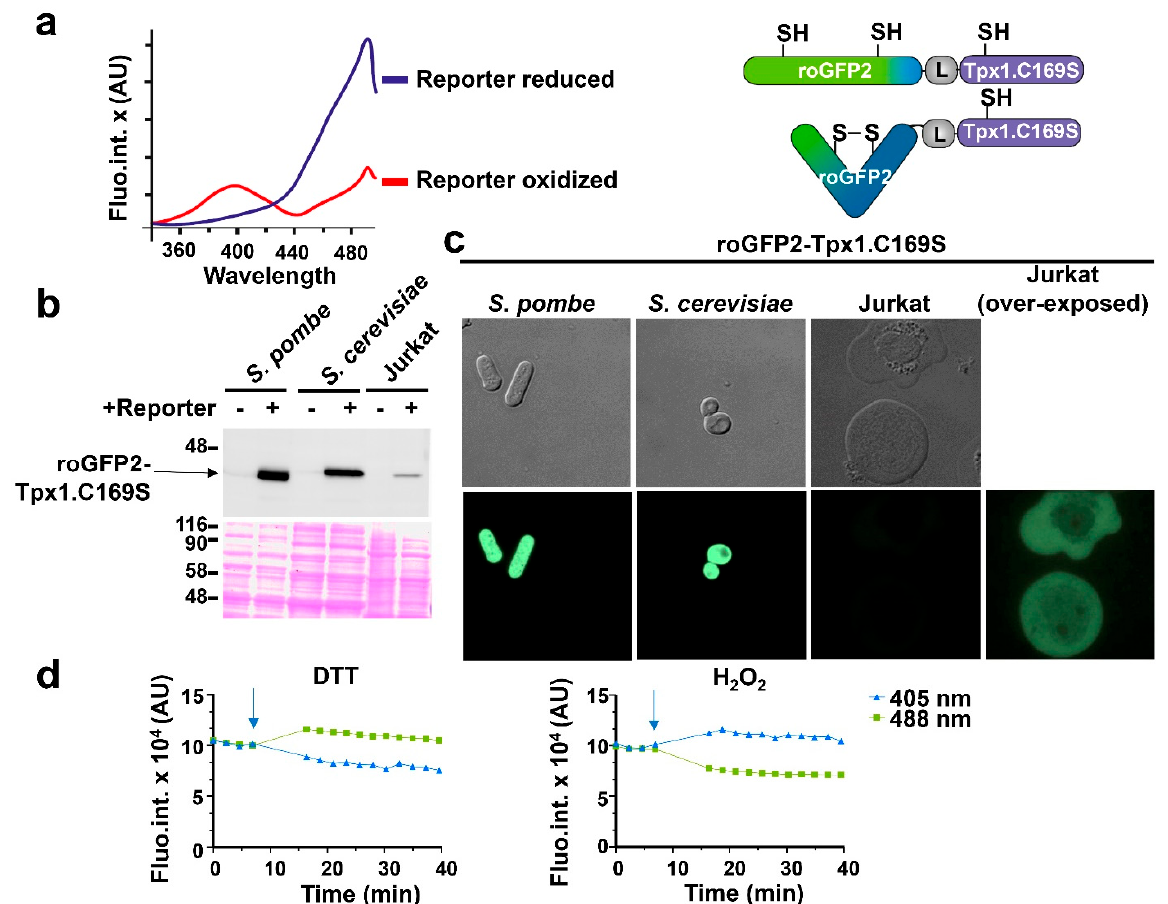
Figure 1. Expression of the H 2 O 2 biosensor roGFP2-Tpx1.C169S in fission and budding yeasts and in Jurkat T cells. ( a ) Left: representation of the fluorescence excitation spectra of reduced and oxidized roGFP2-Tpx1.C169S. The blue line is the fully reduced reporter form and the red line represents the fully oxidized form. X-axis: excitation wavelengths. Y-axis: AU (arbitrary units) of emission fluorescence at 520 nm. Right: representation of the reduced (up) and the oxidized (down) states of roGFP2-Tpx1.C169S. Upon H 2 O 2 treatment, cysteine 48 of Tpx1 oxidizes to sulfenic acid and afterward oxidizes roGFP2, which forms a disulfide bond. ( b ) Western blot of the three used models. Cells expressing or not the probe roGFP2-Tpx1.C169S were processed as described in Materials and Methods. Strains of S. pombe (HM123) and S. cerevisiae (BY4741) were transformed with plasmids p407.C169S and p791 (+) and processed in parallel with their counterparts not expressing the reporter (972 or BY4741, respectively) (-). For Jurkat T cells, extracts from cells stably transfected or not with plasmid p797 to express roGFP2-Tpx1.C169S were grown and processed as described in Materials and Methods. Ponceau staining was used as a loading control. The sizes of molecular weight markers (in kDa) are indicated. ( c ) Micrographs of the three models. Cells were grown in their corresponding media, concentrated, and resuspended in MM (yeasts) or ISO (Jurkat), and loaded on slides for image acquisition. Image brightness and contrast were not adjusted, except when indicated (Jurkat (over-exposed)). ( d ) Graphs showing the time-dependent (X-axis) emission fluorescence (Y-axis, fluorescence arbitrary units, AU) upon excitation at 405 or 488 nm of Jurkat T cells expressing the reporter roGFP2-Tpx1.C169S. The arrows indicate the time of addition of 1 mM of H 2 O 2 or 50 mM of DTT.